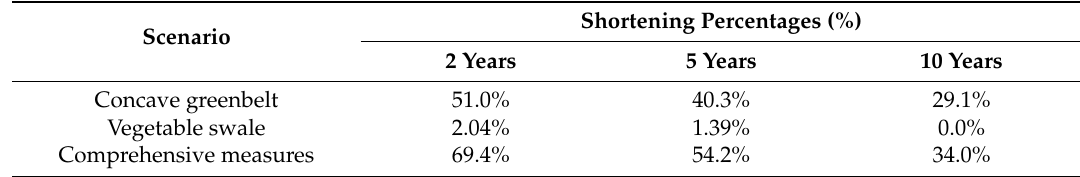
Table 11. Shortening percentages of durations of over 15 cm in different